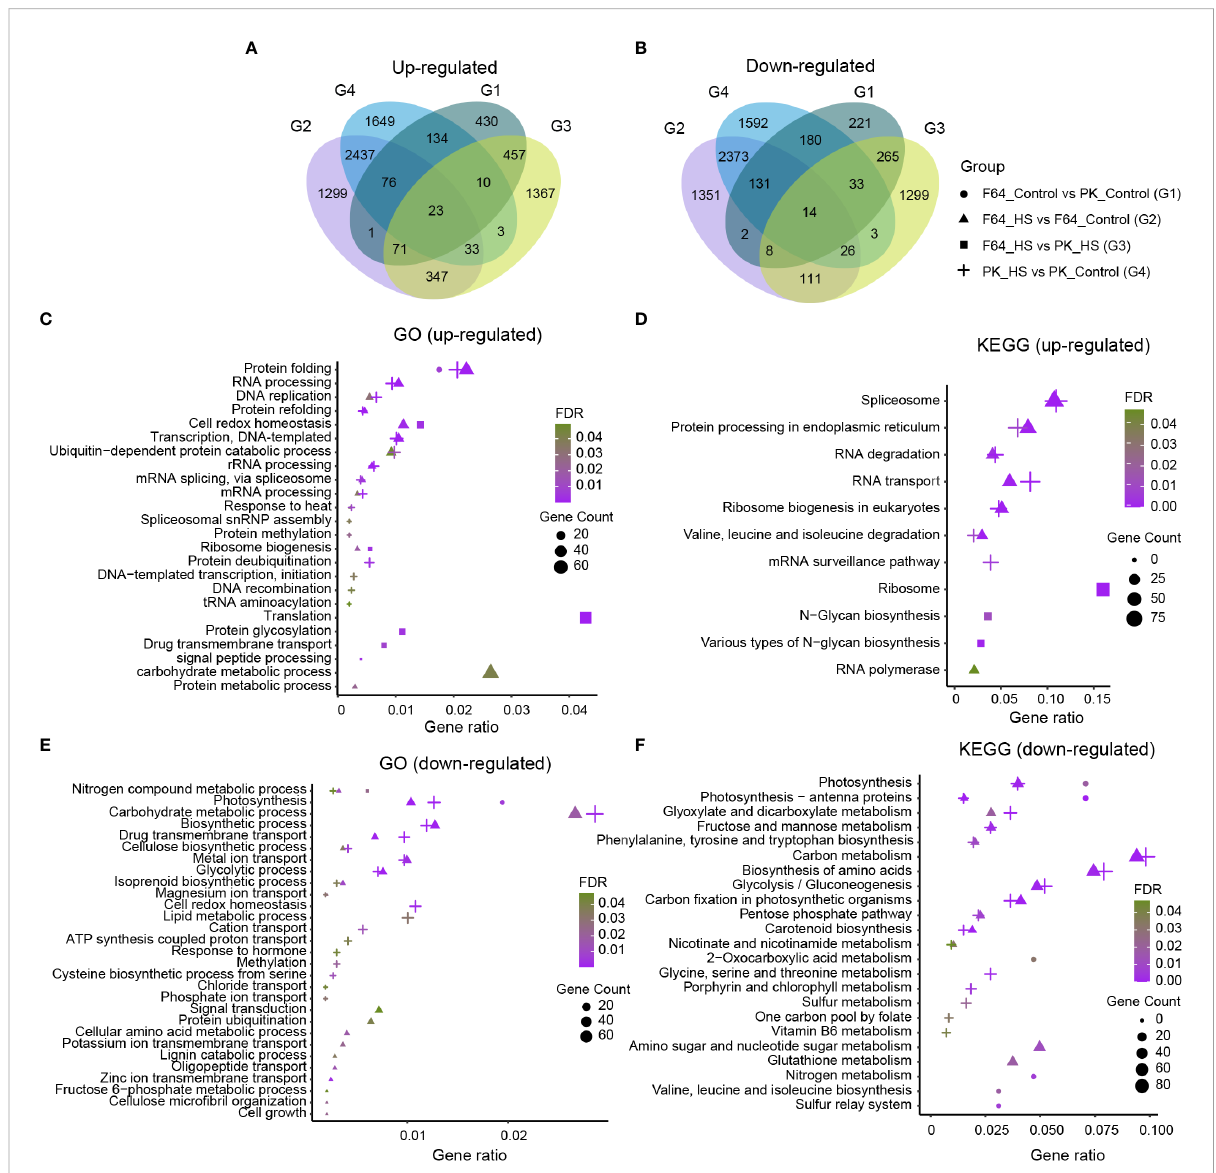
FIGURE 3 The transcriptome analysis of two rice accessions differing in their tolerance to heat stress (HS). (A) Venn diagrams showed the up-regulated differentially expressed genes (DEGs). (B) Venn diagrams showed the down-regulated DEGs. (C, D) GO and KEGG enrichment analysis of up- regulated DEGs. (E, F) GO and KEGG enrichment analysis of down-regulated DEGs. In c, e, only biological process GO terms were shown. G1: F64_Control vs PK_Control; G2: F64_HS vs F64_Control; G3: F64_HS vs PK_HS; G4: PK_HS vs